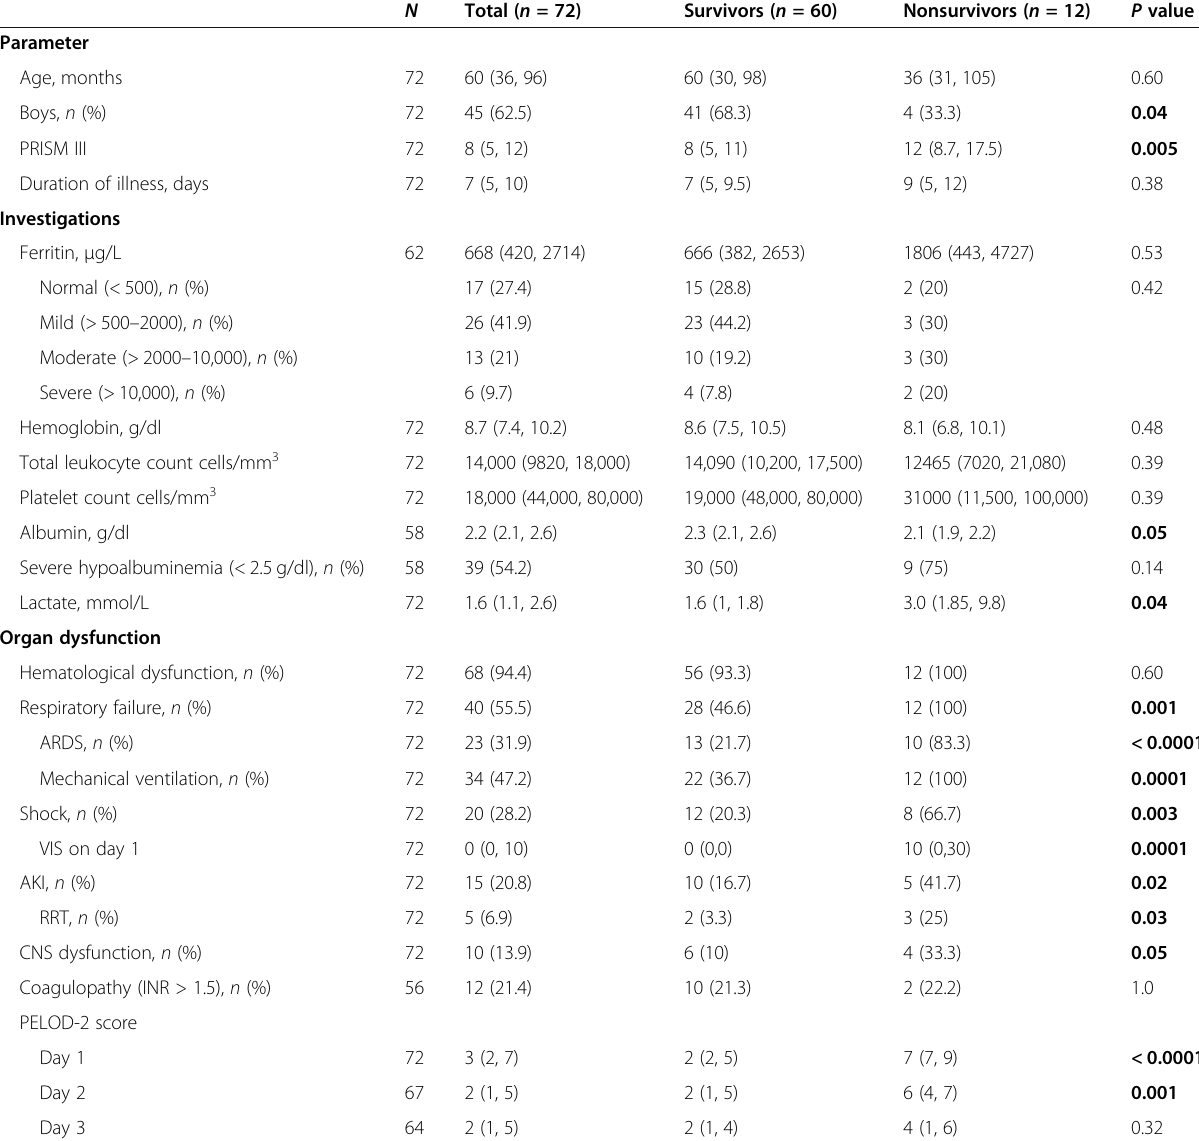
Table 2 Comparison of baseline characteristics among survivors and